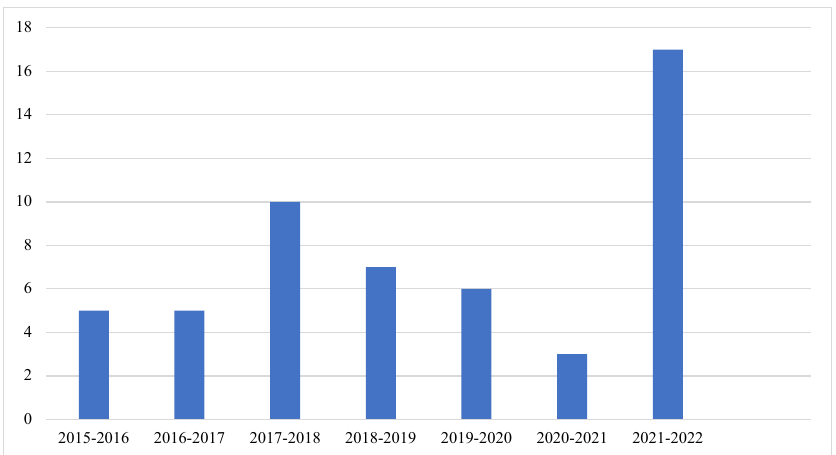
Figure 3. Temporal distribution of selected studies .